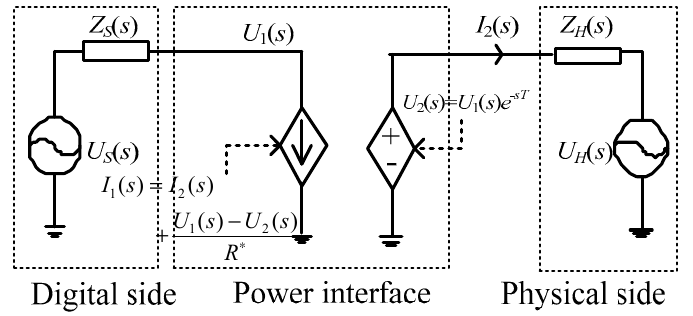
Figure 3. Equivalent circuit of the DPHS based on the improved power interface model.